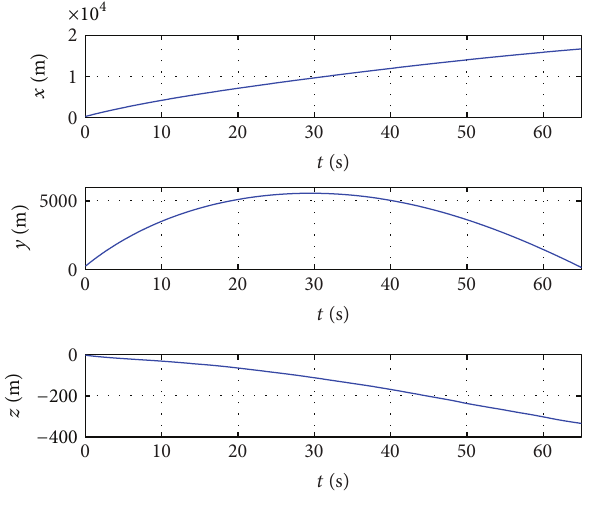
Figure 1: Trajectory of the spinning projectile.